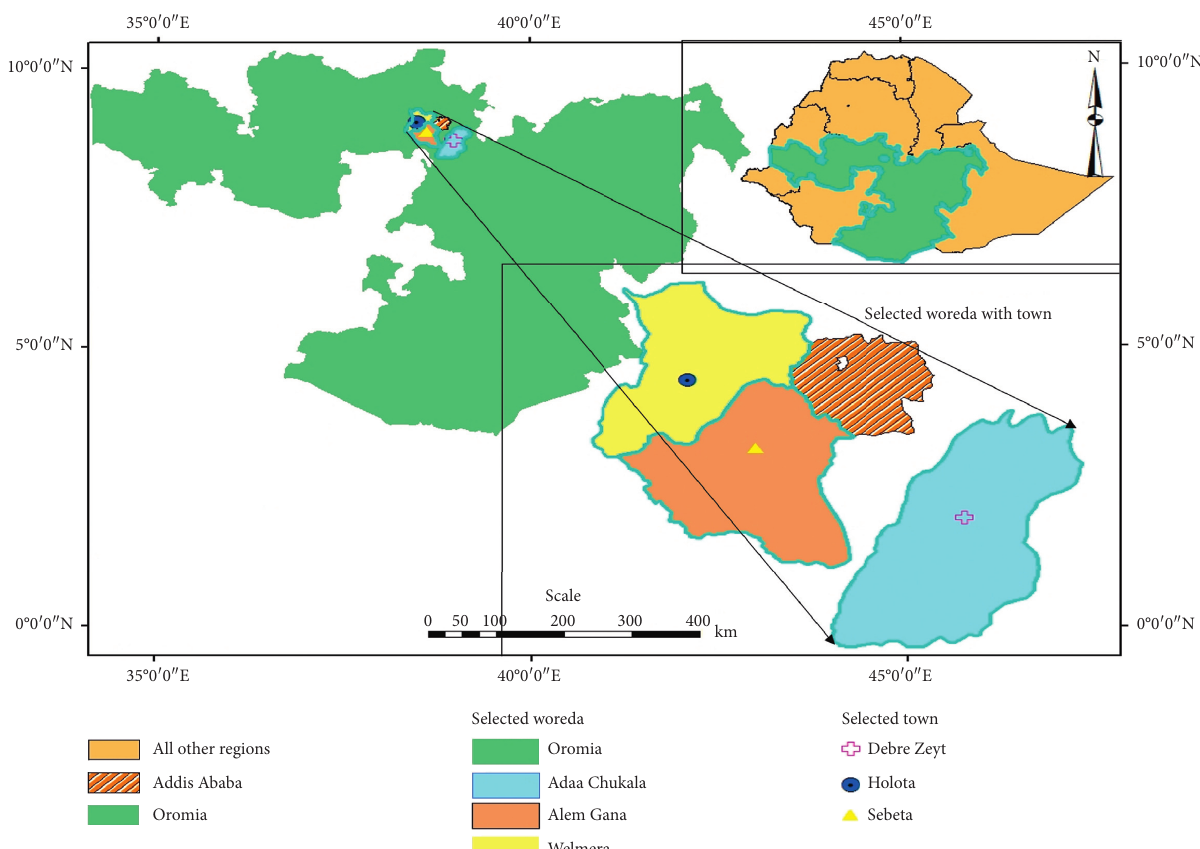
Figure 1: Map of the study area and sampling sites (generated by Umer Seid, corresponding